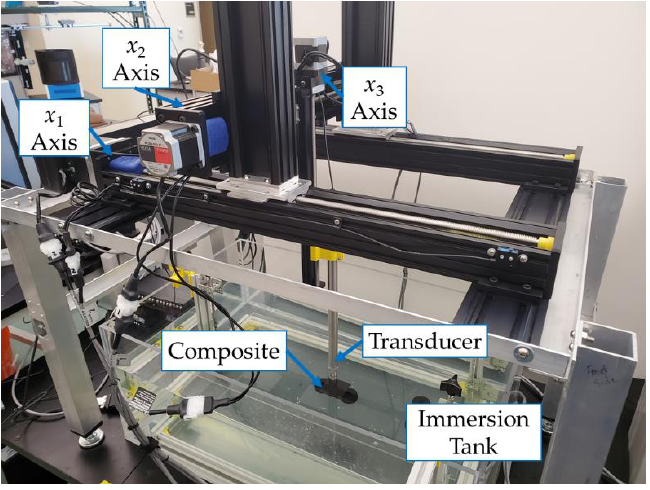
Figure 2. Custom c-scan immersion system used in the present study.